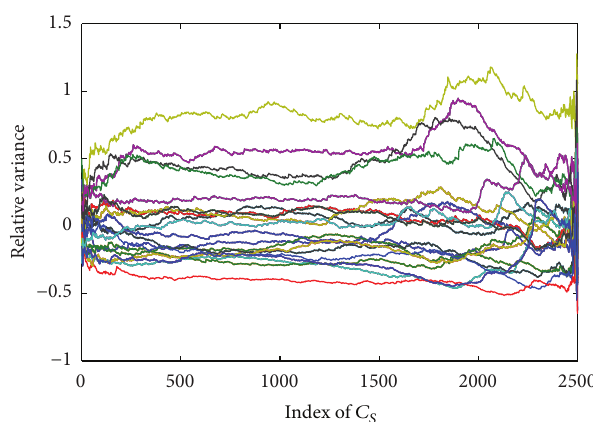
Figure 7: Relative deviations of subgraph centralities 𝐶 𝑆 (𝑖) of the BA scale-free network.